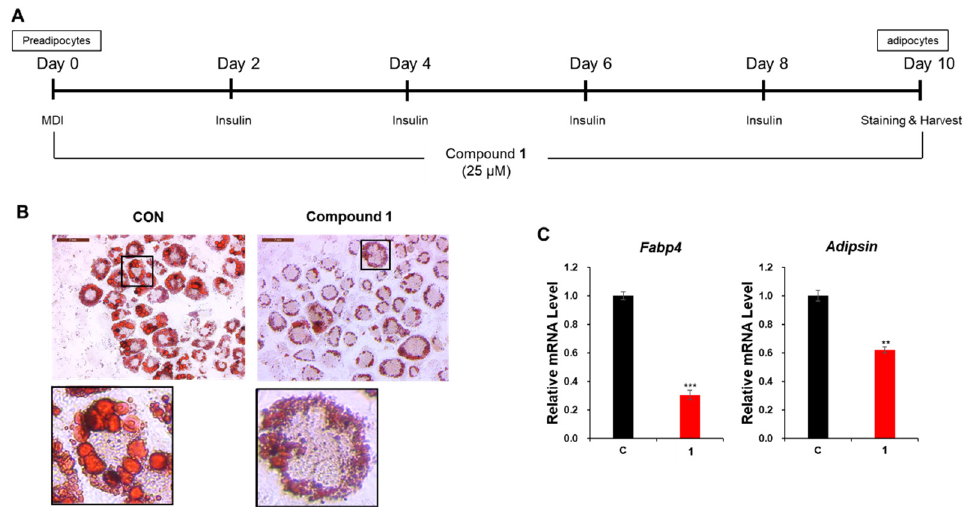
Figure 5. Inhibitory effects of compound 1 on adipogenesis. ( A ) Schematic representation of the differentiation of 3T3-L1 preadipocytes into adipocytes following 10 d of culture. The 3T3-L1 cells were treated with compound 1 during differentiation. ( B ) Images of adipocytes stained with Oil Red O following incubation with 25 μ M of compound 1 during adipogenesis. ( C ) The relative mRNA expression levels of the fatty acid-binding protein 4 ( Fabp4 ) and Adipsin in 3T3-L1 adipocytes incubated with 25 µ M of compound 1 during adipogenesis. The data are presented as the mean ± standard error of the mean (SEM) of n = 3 replicates. ** p < 0.01, and *** p < 0.001.